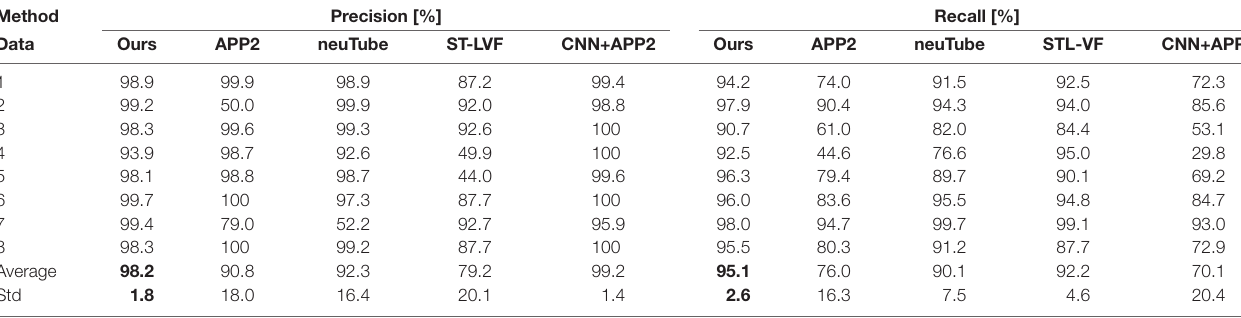
Bold values represent best achieved evaluations and gold